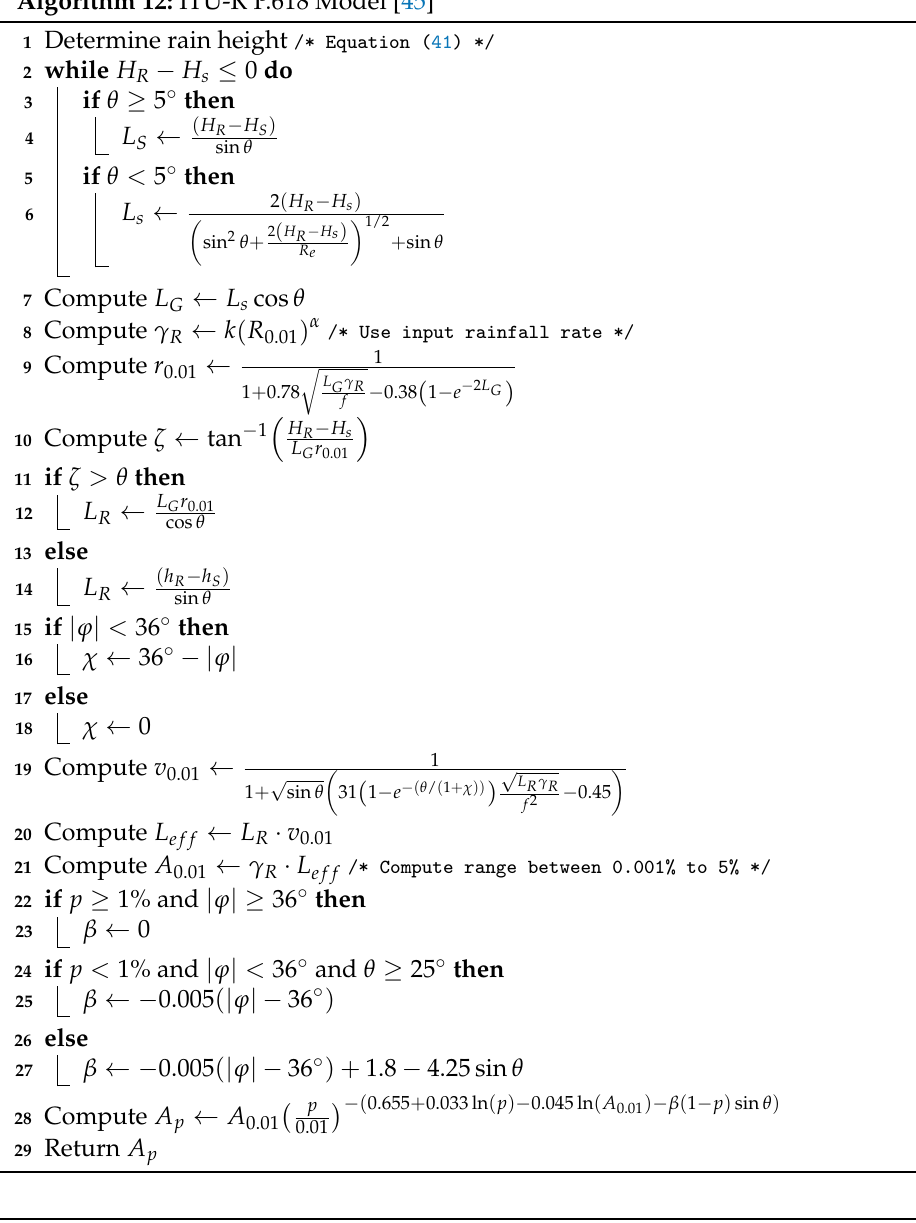
Algorithm 12: ITU-R P.618 Model [45]